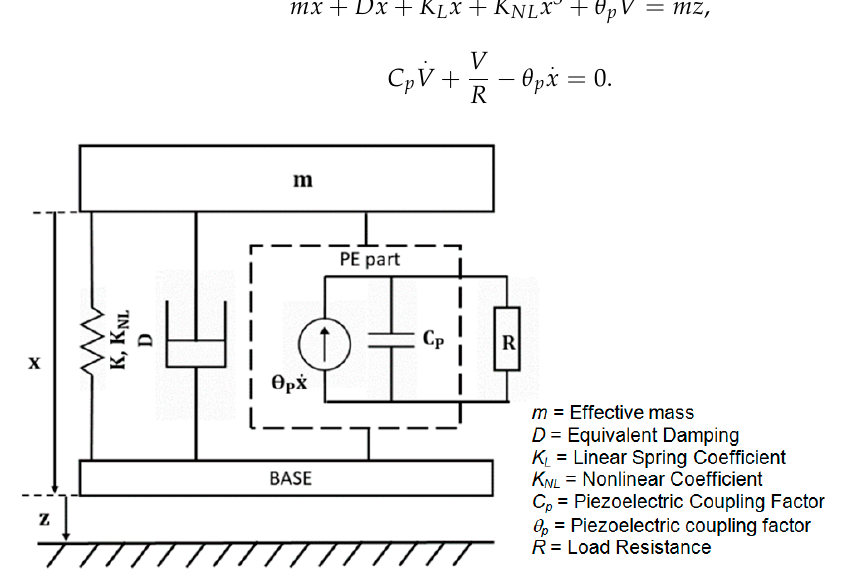
Figure 7. The physical lumped model of the nonlinear PEH.